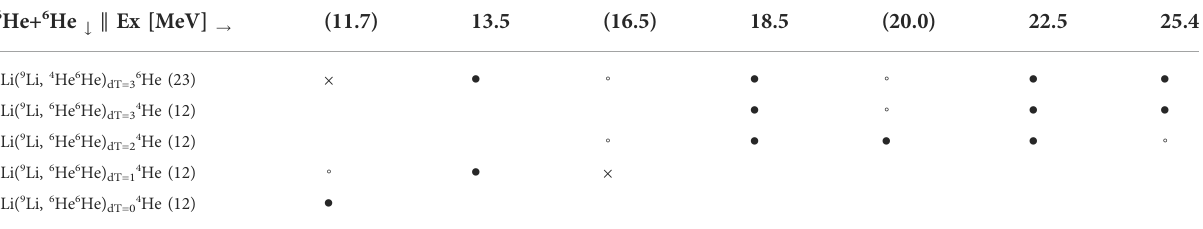
TABLE 1 12 Be excited states observed in the 6 He+ 6 He decay. Observation of a clear peak is labeled with peak obscured by the background or other peaks, or affected by the detection ef fi ciency, with ×. Tentative states are in parenthesis.